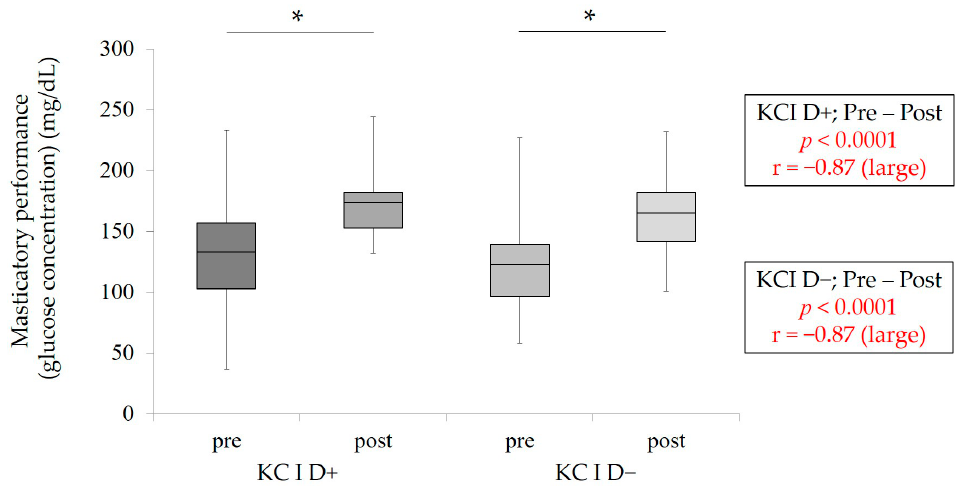
Figure 3. Pre- and post-MPI in in KC I D+ and D − . The statistical analyses were conducted between pre- and post-values in KC I D+ and D − , respectively * p < 0.05, Wilcoxon signed-rank test, r: effect size.